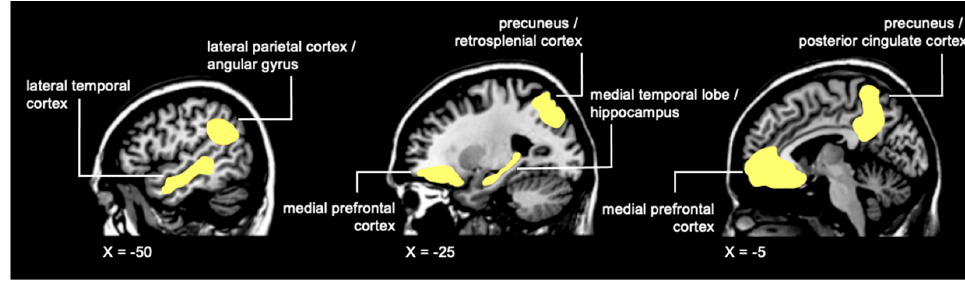
Figure 1. Regions commonly activated during memory recollection, comprising the recollection net ‐ works.